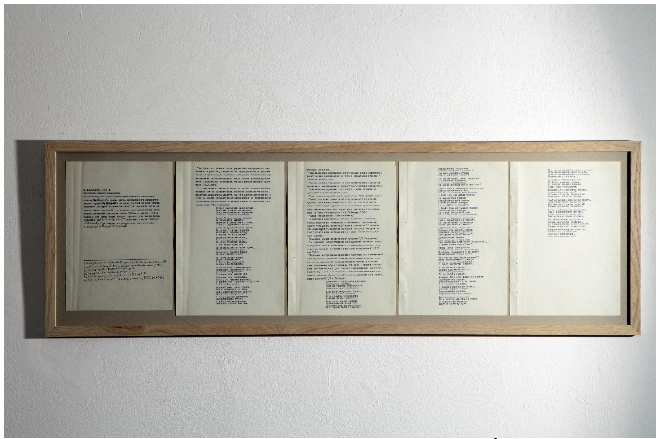
Figure 11. Albert. Art Instead of Philosophy . 1979. Paper. 29.7 cm × 21 cm. Courtesy of the artist.